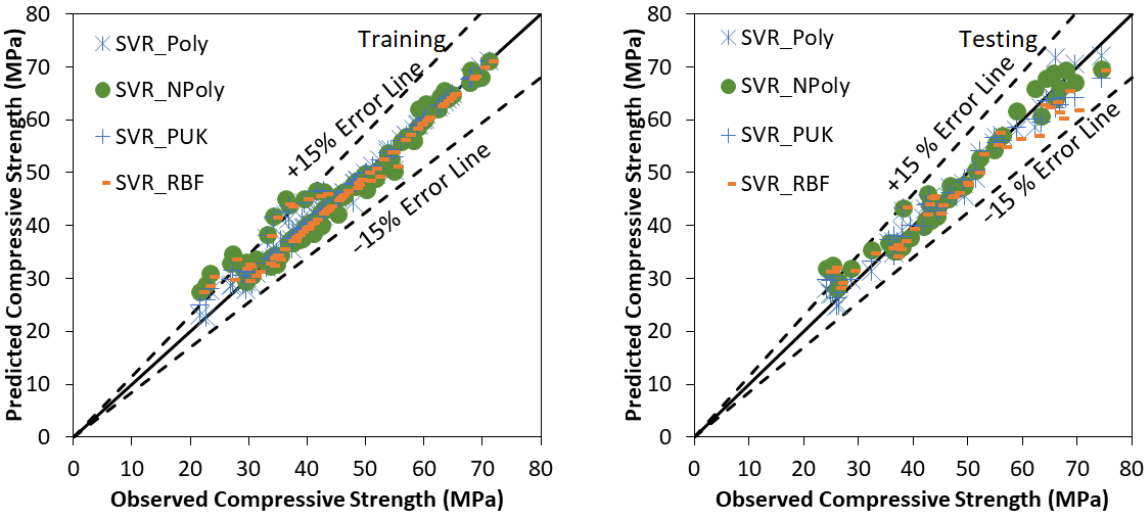
Figure 3. Observed vs. Predicted values using SVR based models using training and testing stage. Table 6. Performance evaluation parameters M5P, RF, RT, REP Tree, SVR_Poly (Polynomial ker-